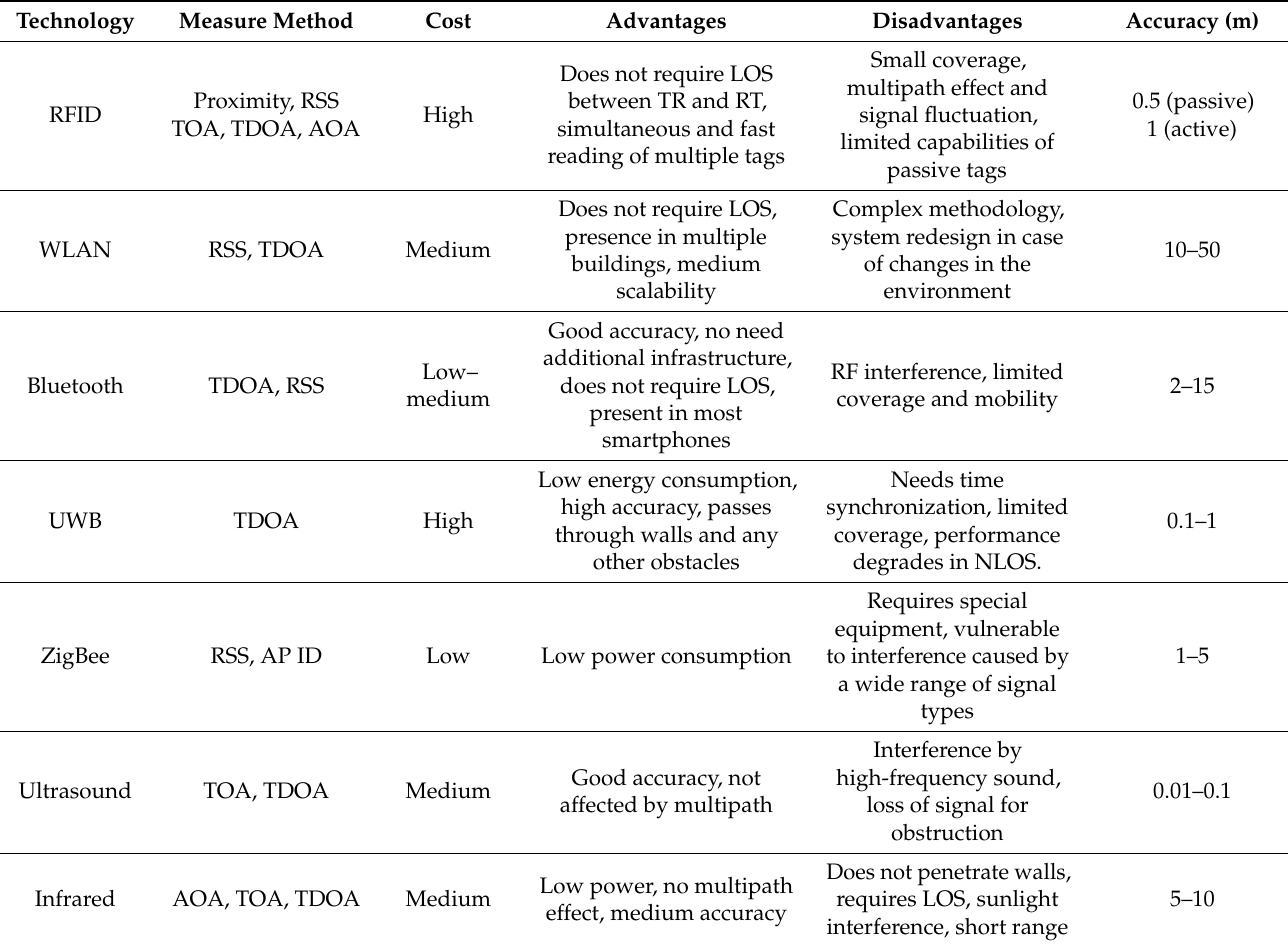
Table 3. Comparison of indoor localization systems.